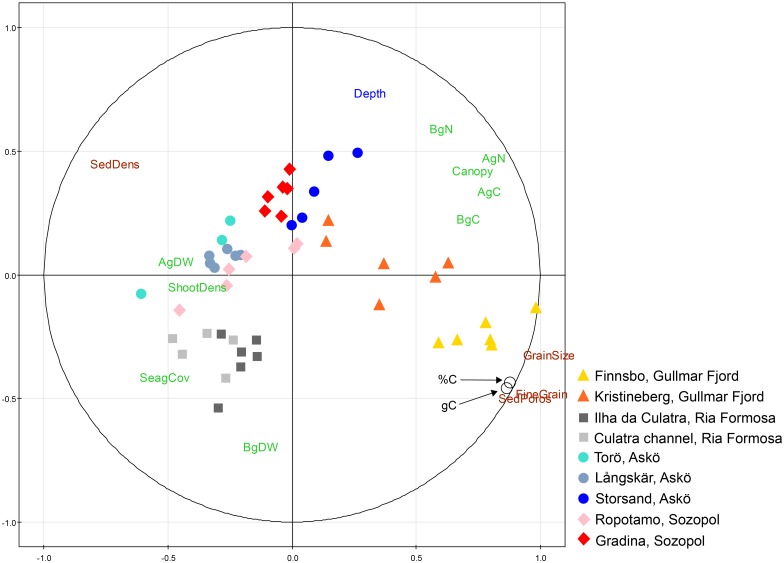
Principal component analysis (PCA) showing the nine seagrass sites, the two response variables (sedimentary % Corg and g Corg cm-2) and predictor variables (14 in total).The percent organic carbon (% Corg) is presented as a mean of the content of the top 25 cm sediment, while carbon per unit area (g Corg cm-2) is the total (accumulated) amount of carbon in the top 25 cm of sediment. The colors of the letters represent different groups of predictor variables; brown letters = sediment characteristics, green letters = seagrass-associated variables, blue letters = water depth. Black circles are the response variables, i.e. organic carbon (%C = % Corg and gC = g Corg cm-2). For explanations to the abbreviations of predictor variables see Fig 4.